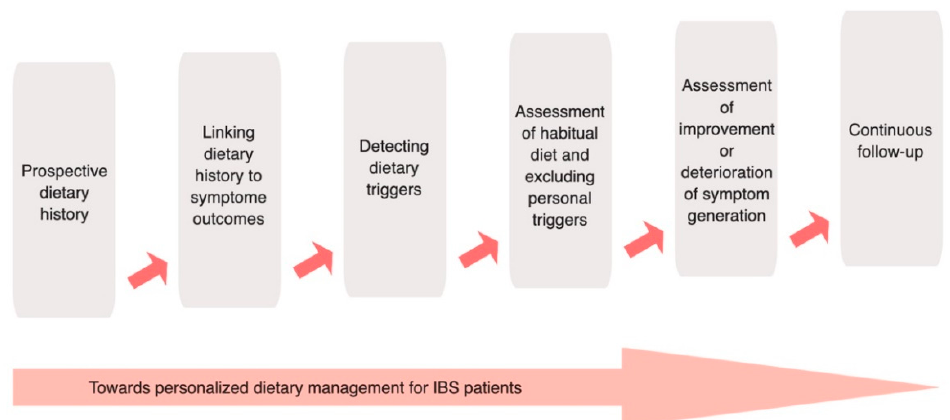
Figure 2. Advise on dietary habits, lifestyle, and how to avoid symptom triggers. Guidelines regarding dietary habits, lifestyle, and avoidance of symptom triggers were already described in early 1990s and were based on clinical experience. This approach can still be used to work towards a personalized dietary management of IBS patients. Abbreviation: IBS: irritable bowel syndrome. Created with BioRender.